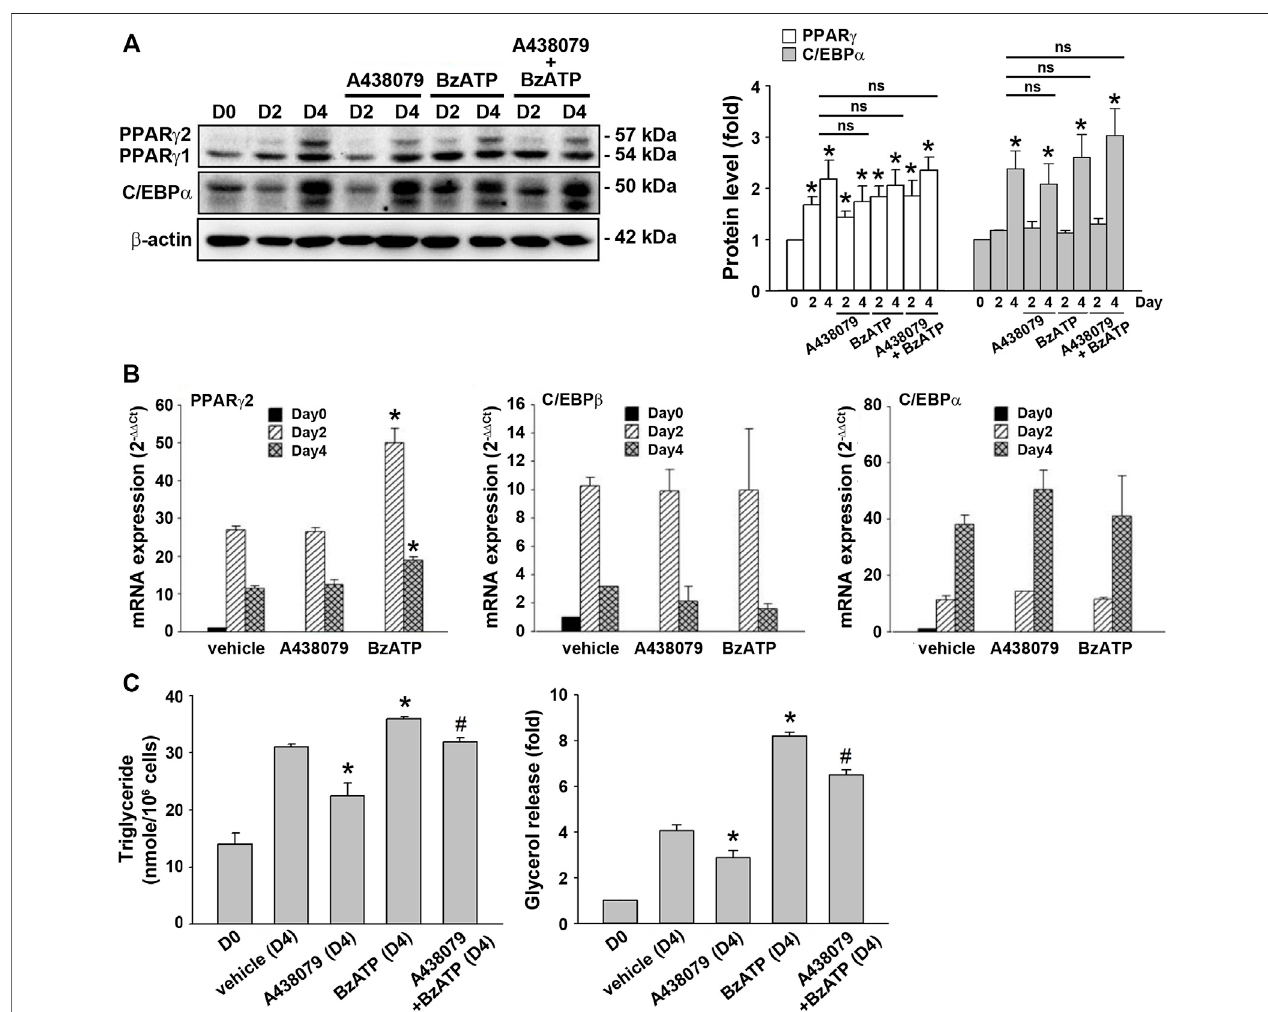
FIGURE2| P2X7doesnotaffectadipocytedifferentiationbutenhanceslipidmetabolism.3T3-L1preadipocytesweredifferentiatedinthetwo-stagemodelforfour days. Vehicle, A438079 (10 μ M) or BzATP (50 μ M) were administered at D0 and again at the end of D2 upon the renewal of the differentiation media. (A) The protein levels of PPAR γ and C/EBP α at D0, the end of D2, and the end of D4 during adipocyte differentiation were determined by western blot analysis and quanti fi ed by normalizing to β -actin from three independent experiments. * p < 0.05 vs . vehicle-treated preadipocytes at D0. ns: non-signi fi cant. (B) The gene expression of PPAR γ 2 , C/EBP β , and C/EBP α during adipocyte differentiation was measured by qPCR. * p < 0.05 vs . vehicle-treated adipocytes. (C) Levels of intracellular triglyceride and released glycerolinculture medium at the end ofD4 weredeterminedby triglyceride assaykit (Abcam) and adipolysis assay kit (Millipore), respectively. * p < 0.05 vs . vehicle-treated adipocytes at D4 and # p < 0.05 vs . BzATP-treated adipocytes at D4. All quantitative data are presented as mean ± SEM from at least three independent experiments.